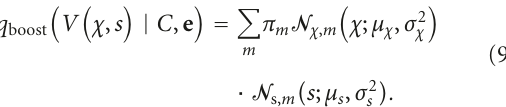
Figure 25: Examples of proposed distribution: category sampling, ROI sampling, and figure-ground